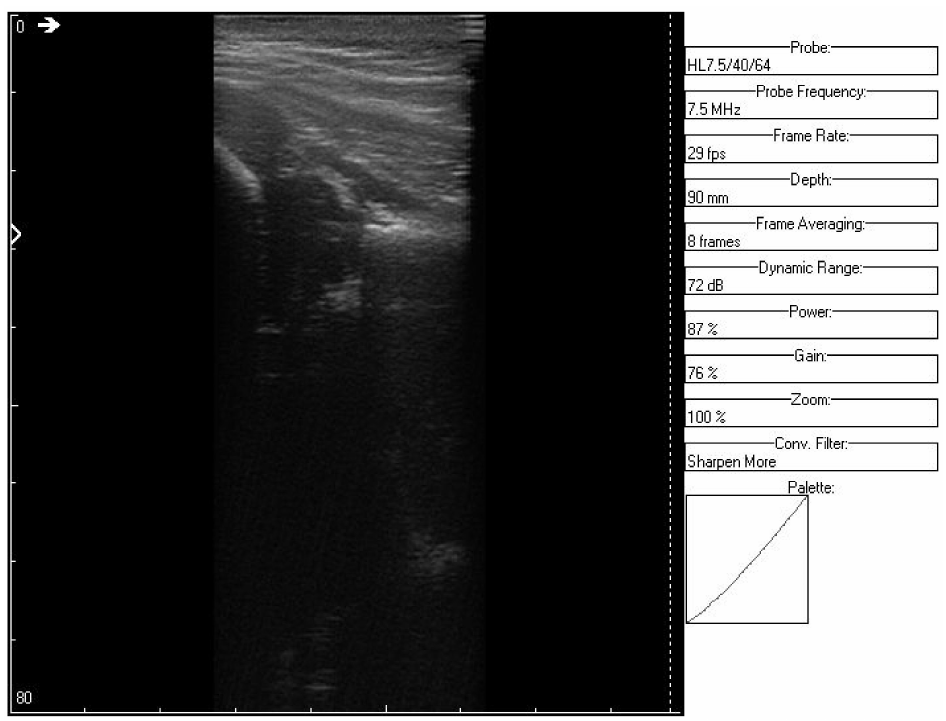
Figure 10. Original data, Image